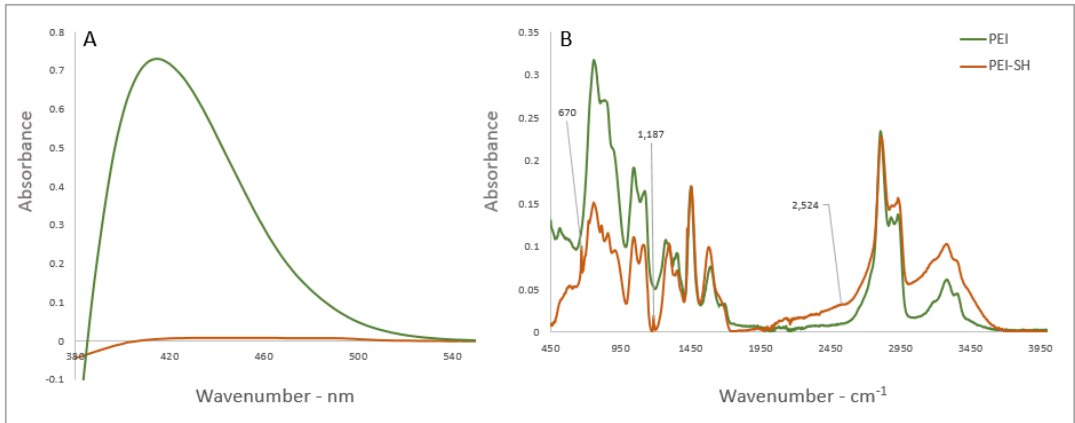
Figure 1. ( A ) UV–VIS spectra of TNB, the decomposition product of Elman’s reagent and; ( B ) ATR-FTIR spectra of bPEI-SH and bPEI neat.